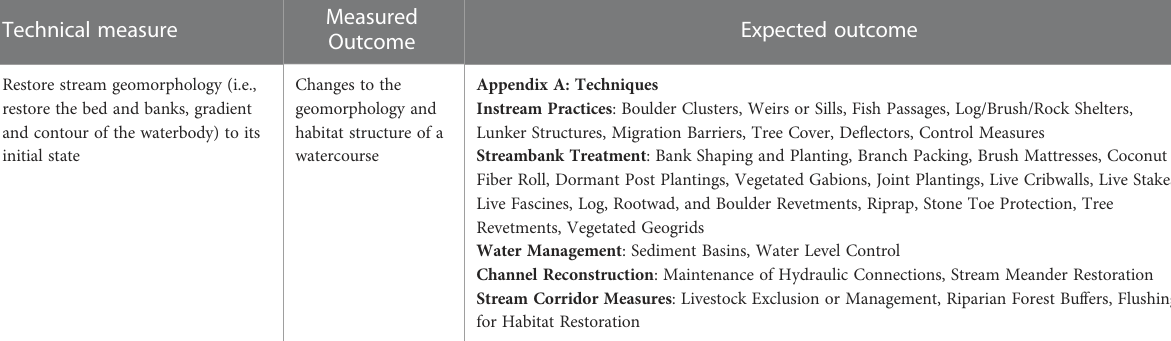
Expected outcome